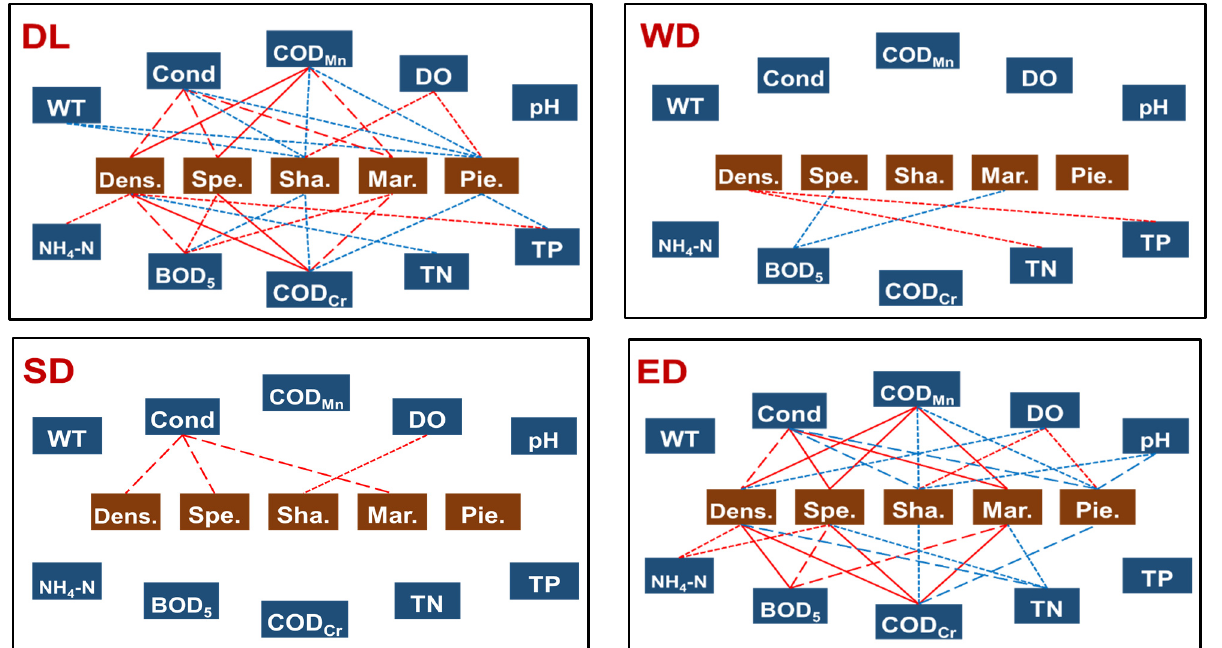
Figure 5. Driving diagram of environmental factors to phytoplankton community. Note: The correlation between the physicochemical indicators and the phytoplankton indicators. Density, species, Scheme 0.1< R < 0.4) and significance ( p < 0.05); the dashed line ”– –– –” indicates the correlation coefficient (0.4 < R < 0.7) and significance ( p < 0.05), and the solid line “——” indicates the correlation coefficient ( R > 0.7) and significance ( p < 0.01).